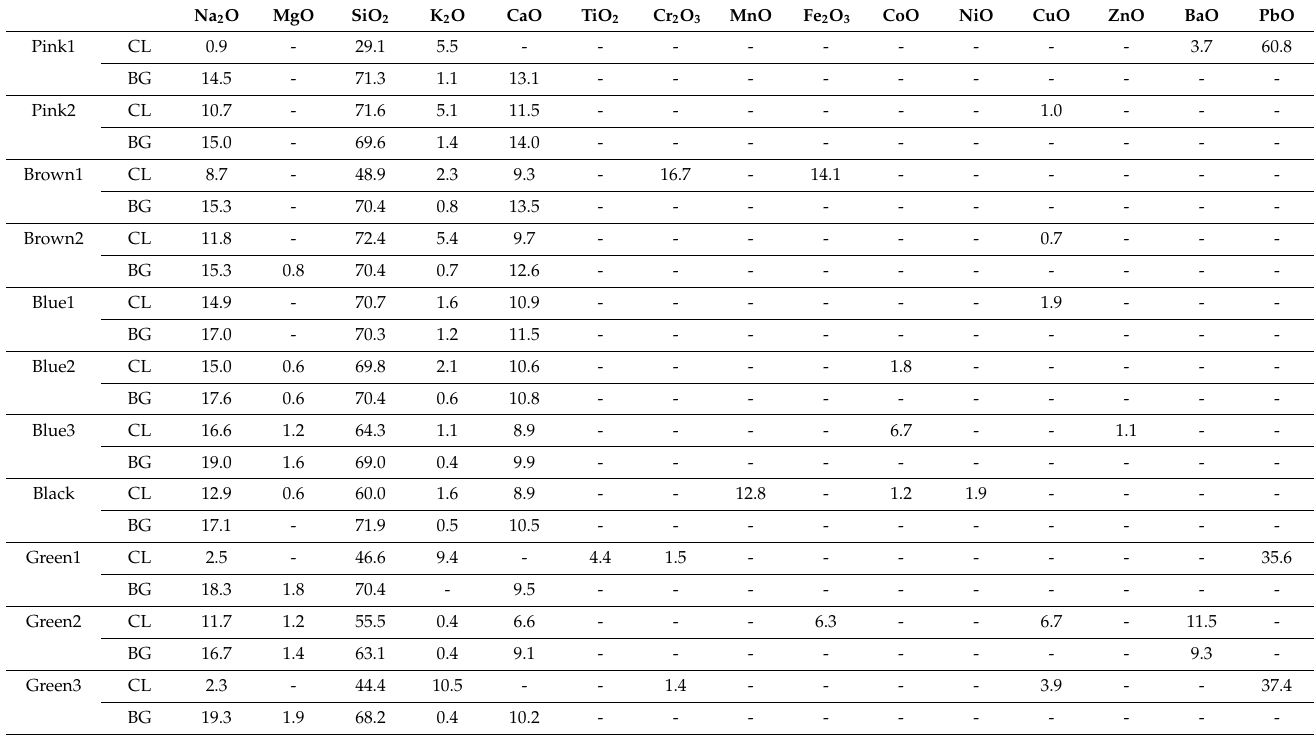
Table 2. Chemical composition (wt.%) of the surface-colored layer and of the base glass analyzed by FESEM-EDS. CL: Colored layer, BG: Base